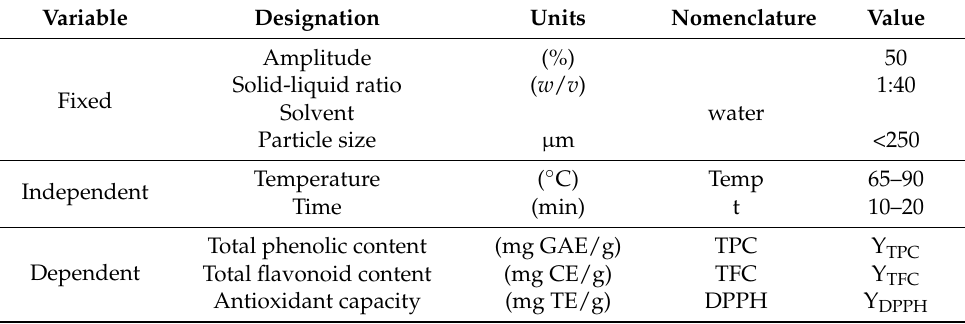
Table 3. Experimental variables of the experimental design.